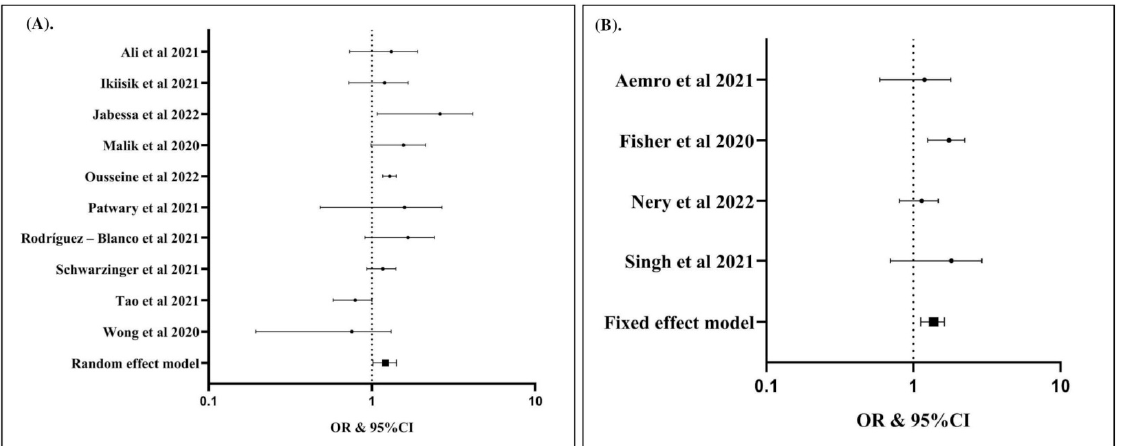
Figure 4. Unemployed individuals were associated with increased risk of hesitancy to COVID-19 vaccination compared to working individuals (OR: 1.20; 95% CI: 1.02, 1.42; p Egger: 0.1790; p heter- ogeneity: 0.0090; p : 0.0300) ( A ); individuals with household number ≥ 5 individuals had higher risk of hesitancy to COVID-19 vaccination (OR: 1.36; 95% CI: 1.13, 1.63; p Egger: 0.1680; p heterogeneity: 0.1620; p : 0.0010) ( B ). The studies included are provided in the reference list [19,25–79].